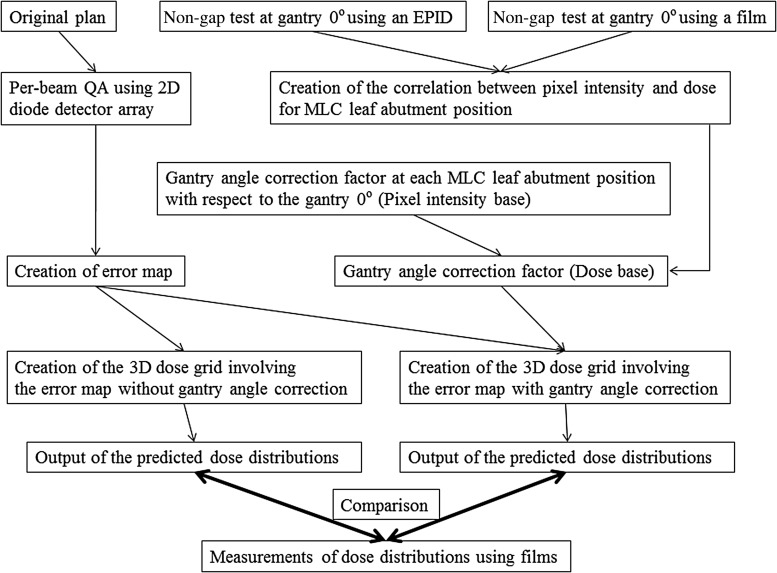
Dose verification procedures for our proposed method with and without GAC.